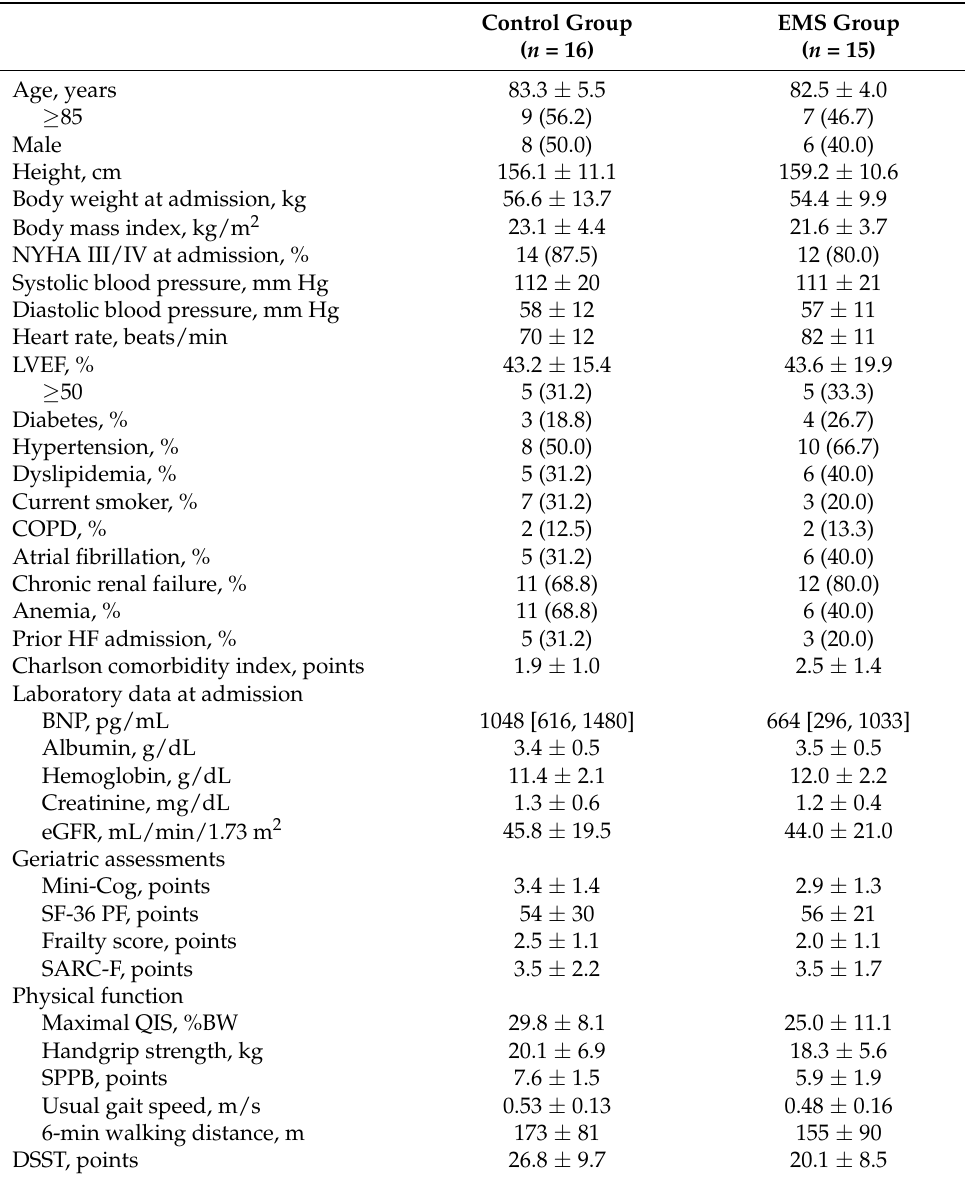
Table 1 shows the demographic and clinical characteristics of the study population at baseline—a mean of 2.7 ± 1.2 days (median, 3 days) was determined after hospitalization. The study population had a mean age of 82.9 ± 4.8 years, 54.8% were women, mean LVEF was 43.4 ± 17.4%, and 32.3% had preserved ejection fraction. The rates of hypertension, renal failure, and anemia in the study population were high. The patients had severe impairment of physical function and at least mild cognitive dysfunction at baseline. Table 1. Baseline